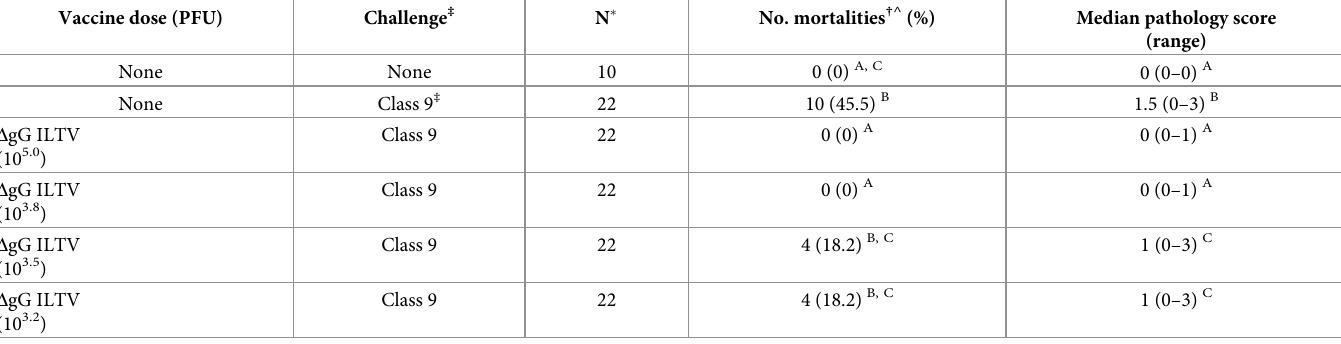
Table 4. Mortality rates and gross pathological scores in unvaccinated birds and in birds vaccinated with different doses of Δ gG ILTV vaccine via eye-drop at day 7 after challenge. Vaccine dose